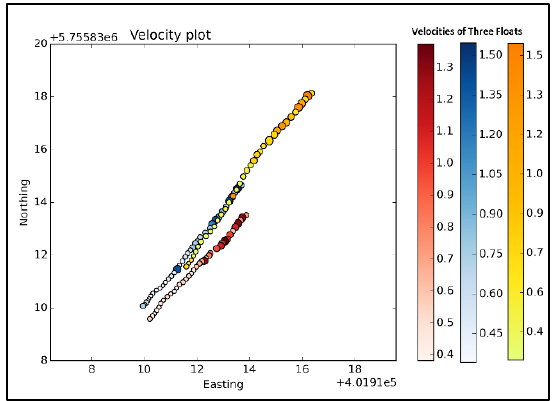
Figure 5. A plot of the velocity of the three floats colour coded into red, blue and yellow. Other than colour, the size of the points are directly proportional to